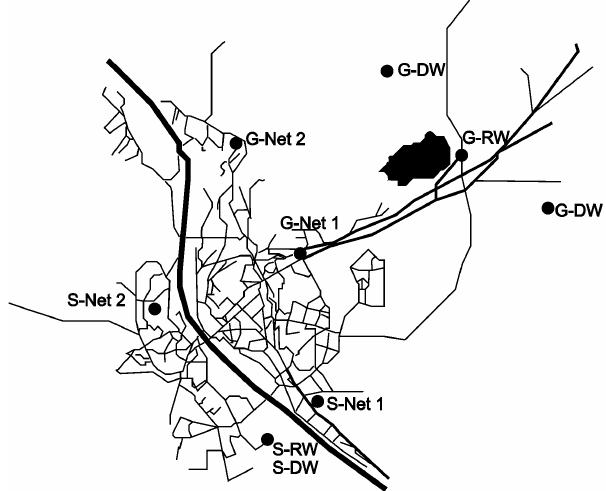
Figure 1. Riga drinking water distribution network with 9